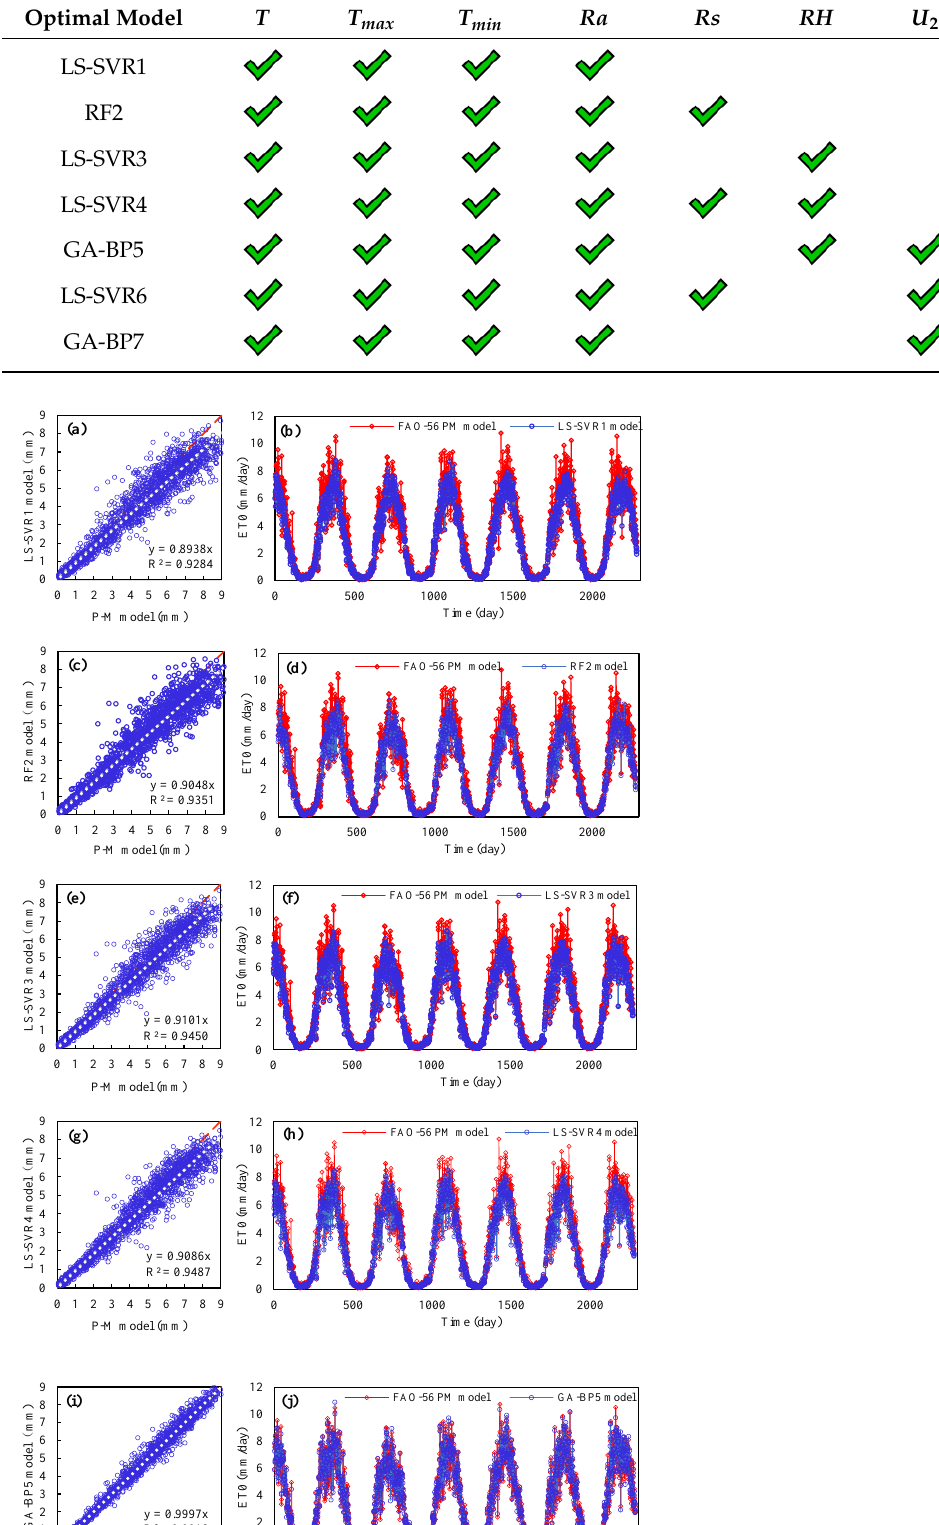
Table 6. The optimal model of different parameter combination input.